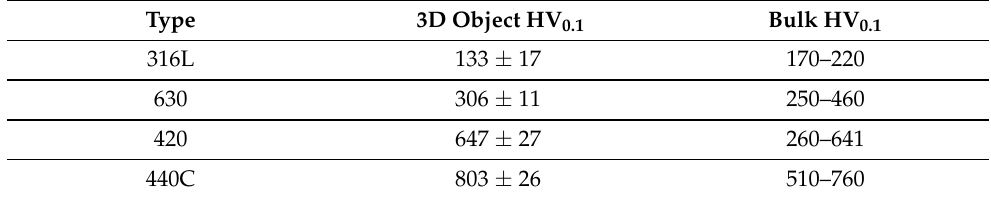
Table 6. Microhardness levels of the selected stainless steel 3D objects, compared to the bulk